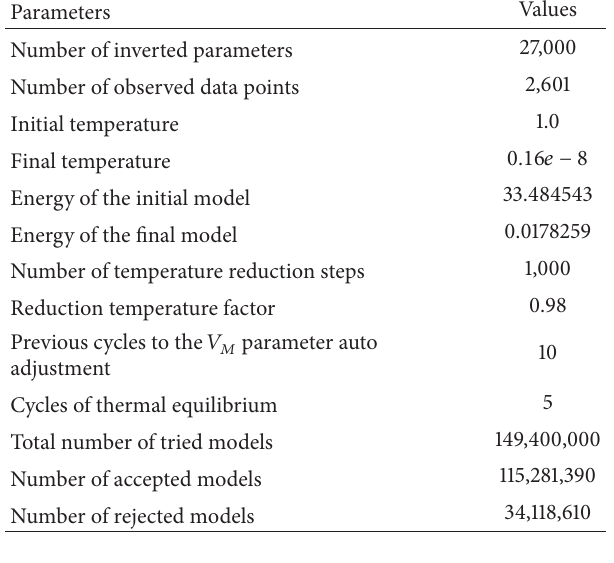
Table 3: Parameter values related with the 3D gravity data inversion procedure.